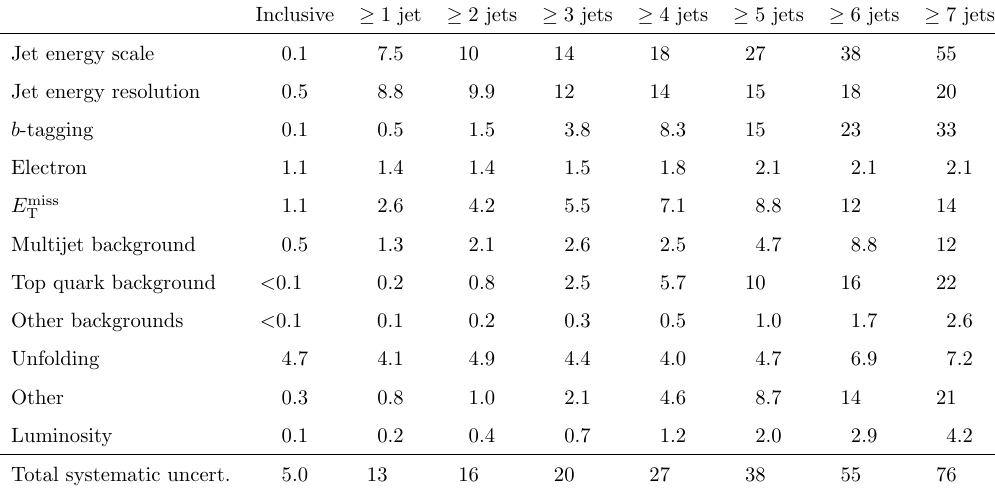
Total systematic uncert. Table 3 . Relative systematic uncertainties in the measured W + jets cross sections in percent as a function of the inclusive jet multiplicity. The uncertainty from b -tagging includes the uncertainties in the b -tagged jet identi(cid:12)cation and misidenti(cid:12)cation e(cid:14)ciencies as well as the impact of W + c; c (cid:22) c; b (cid:22) b cross sections in the extrapolation from the signal region to the (cid:12)ducial region. Other backgrounds summarises the impact of Z and diboson cross sections as well as the statistical uncertainty in the background estimates. Other combines uncertainties in the pile-up modelling and the impact of matching jets to the primary vertex.